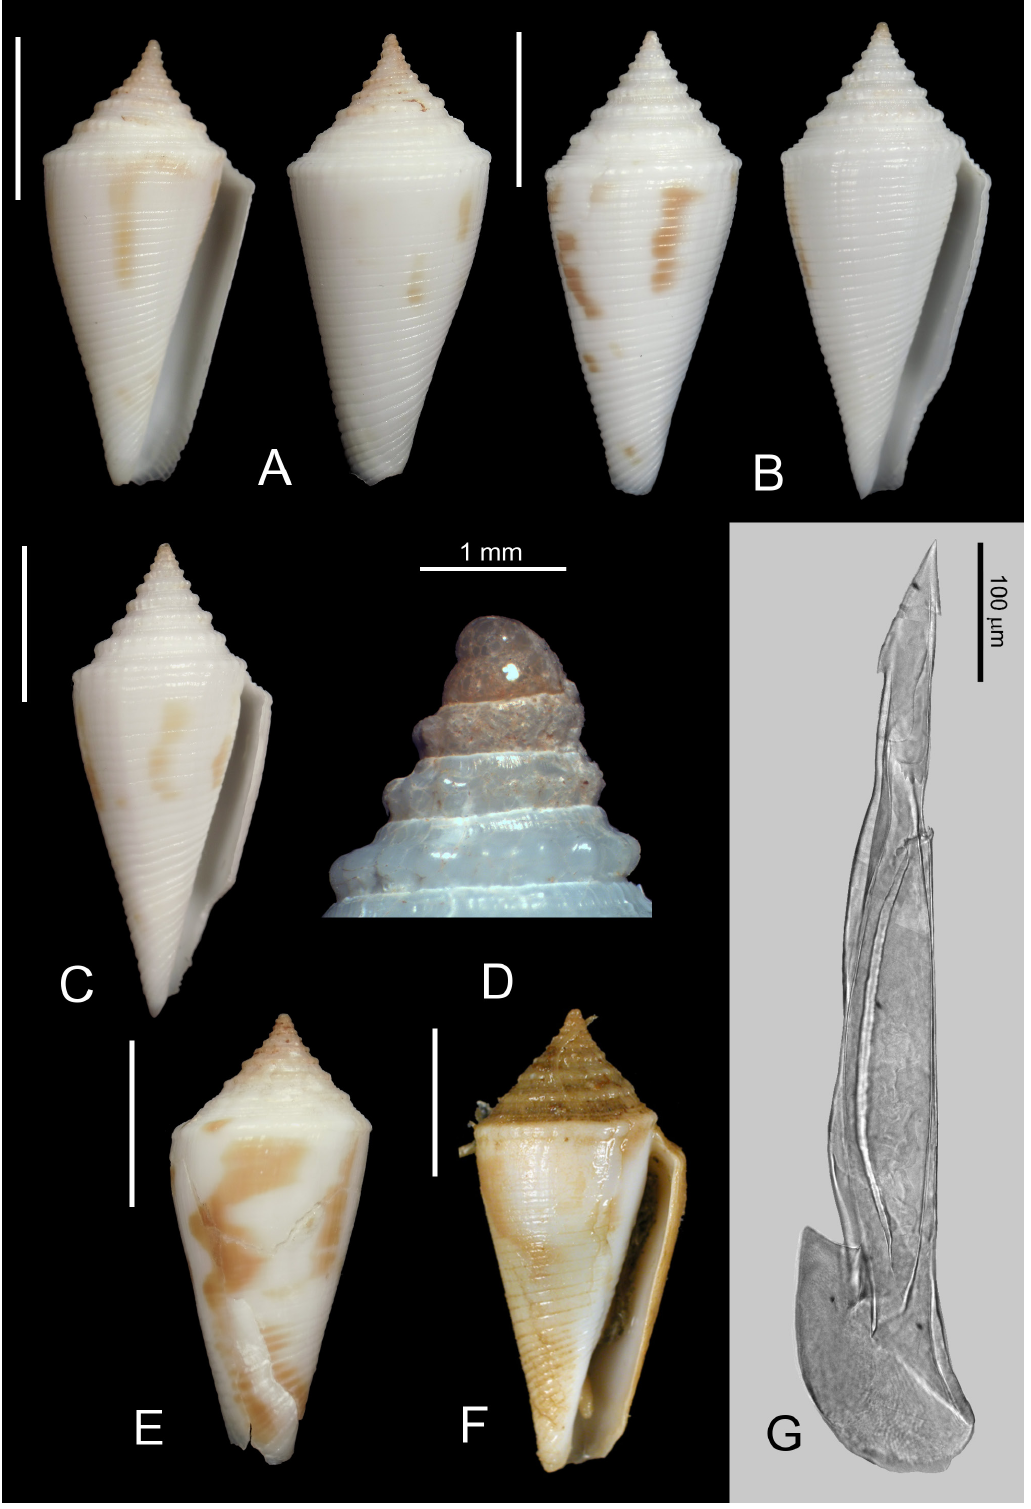
Fig. 7. Profundiconus maribelae sp. nov. A . Holotype, 27.5 × 12.6 mm. B . Paratype 1, 30.0 × 12.5 mm. C . Paratype 2, 30.4 × 13.1 mm. D . Paratype 2, enlargement of the spire. E . Paratype 3 (broken shell), 27.2 × 12.4 mm. F . Sequenced specimen (MNHN IM-2007-34879), 31.5 × 14.4 mm. G . Radular tooth from paratype 1. Scale bars = 10 mm unless otherwise